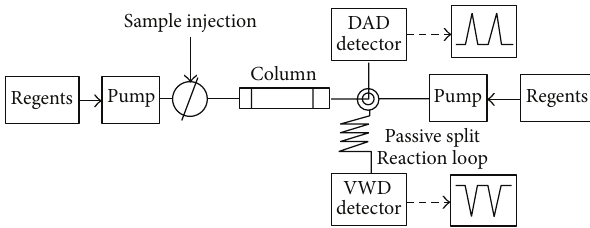
C 18 , Daejeon, Korea). The injection volume was 10 𝜇 L, and the flow rate of the mobile phase was 1.0 mL/min. The